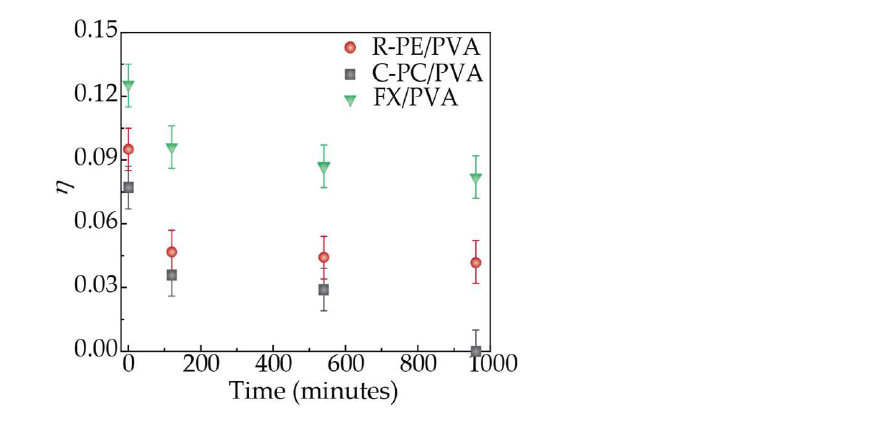
Figure 4. Time-dependent η values of the solid samples upon continuous exposure to an AM1.5G solar simulator for 960 min.